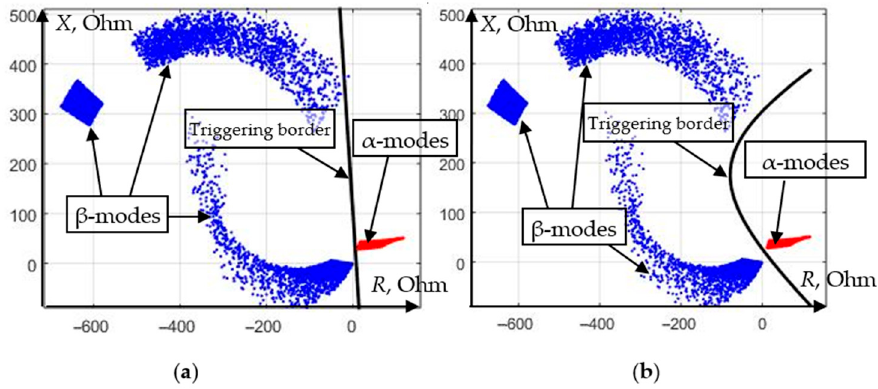
Figure 20. The separating border of the classifier “SVM ω 3 ”: ( a ) Using the linear kernel function; ( b ) using the polynomial kernel function ( p = 2).